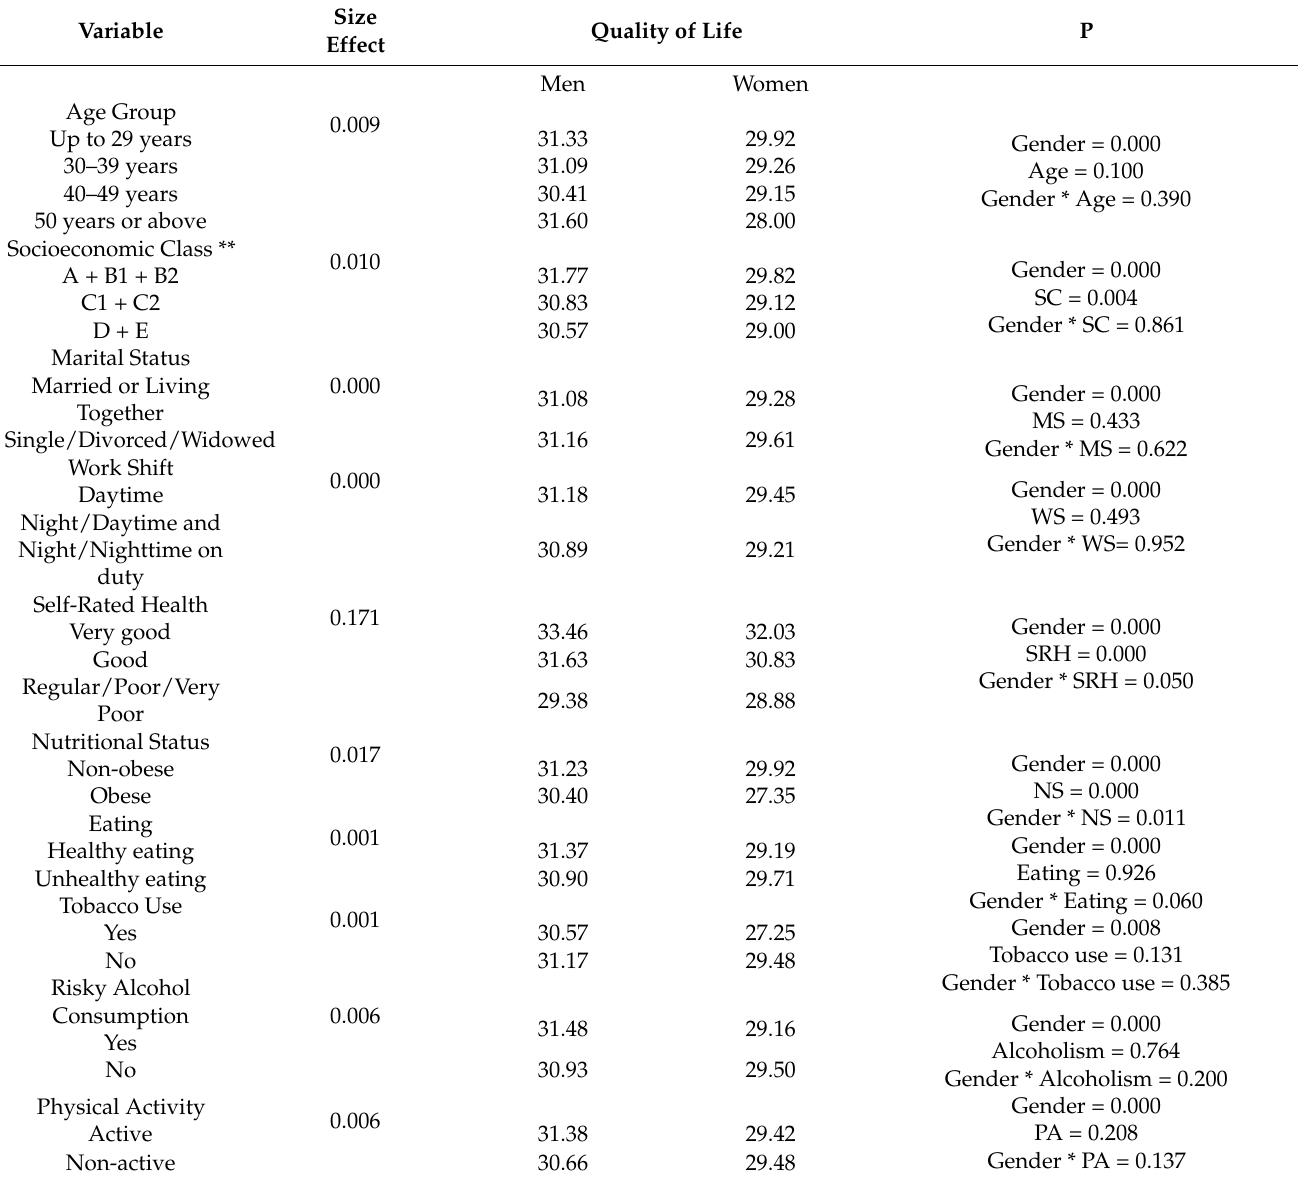
Table 3. Quality of life and demographic, socioeconomic, and clinical characteristics of working men and